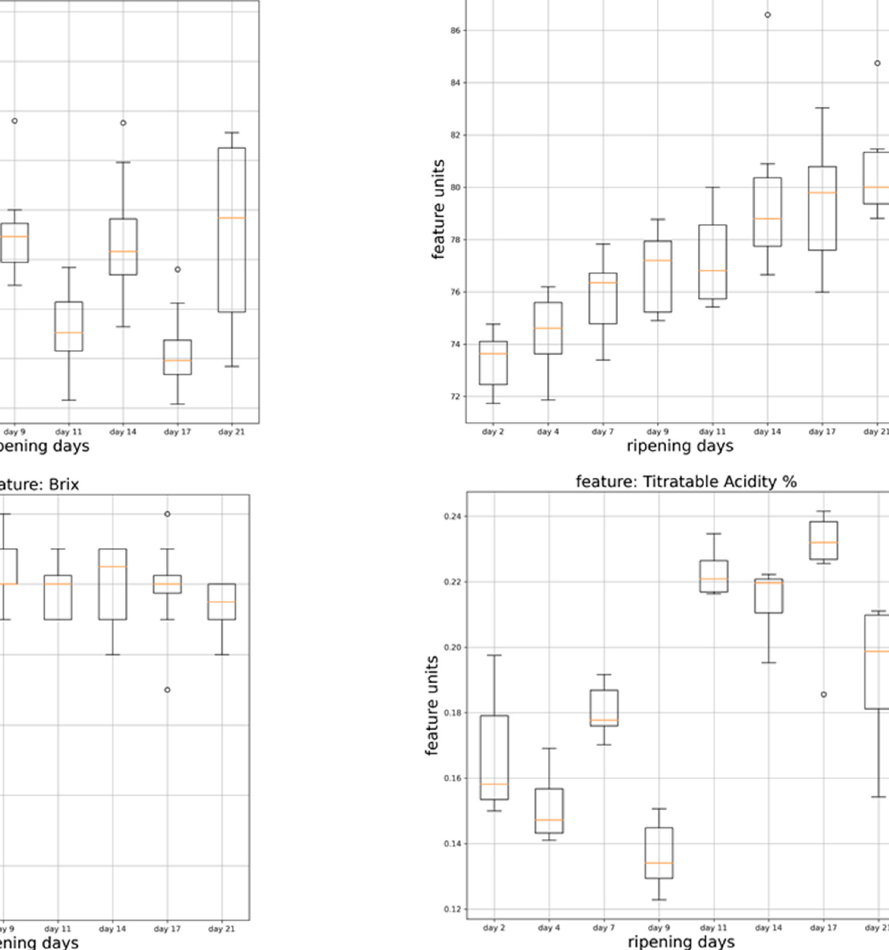
Figure 5. Water activity (aw), moisture content (%), Brix, and titratable acidity (%) of the banana-flesh samples during storage at 18.0 ± 0.5 °C.